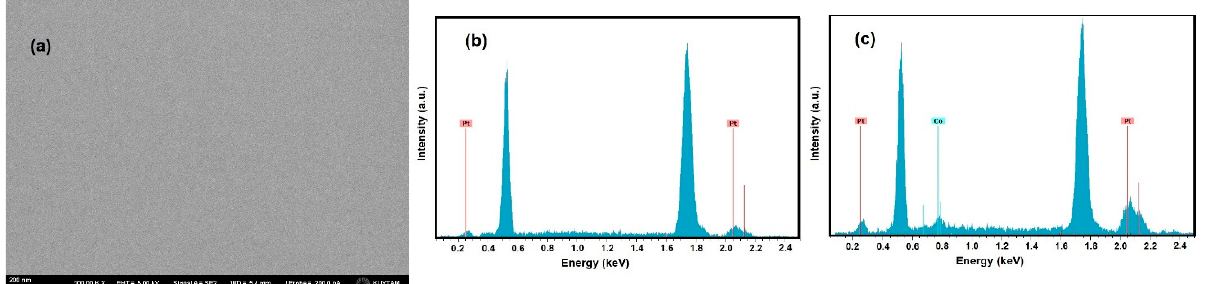
Figure 2. SEM image of Pt 0.5 Co 0.5 alloy ultrathin film ( a ), EDX spectrum of Pt ( b ), and Pt 0.75 Co 0.25 ( c ) alloy ultrathin films. ( c ) alloy ultrathin